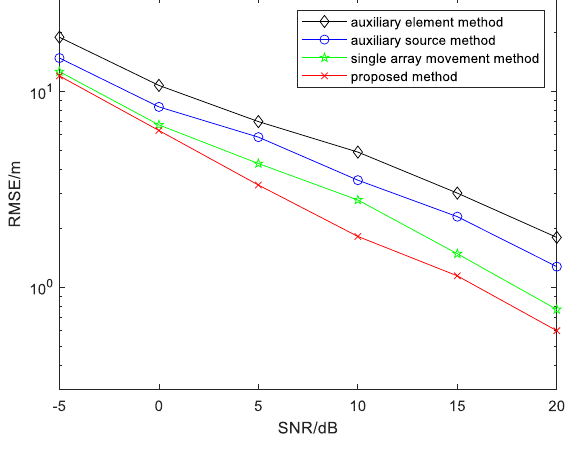
Figure 5. RMSE vs. SNR.